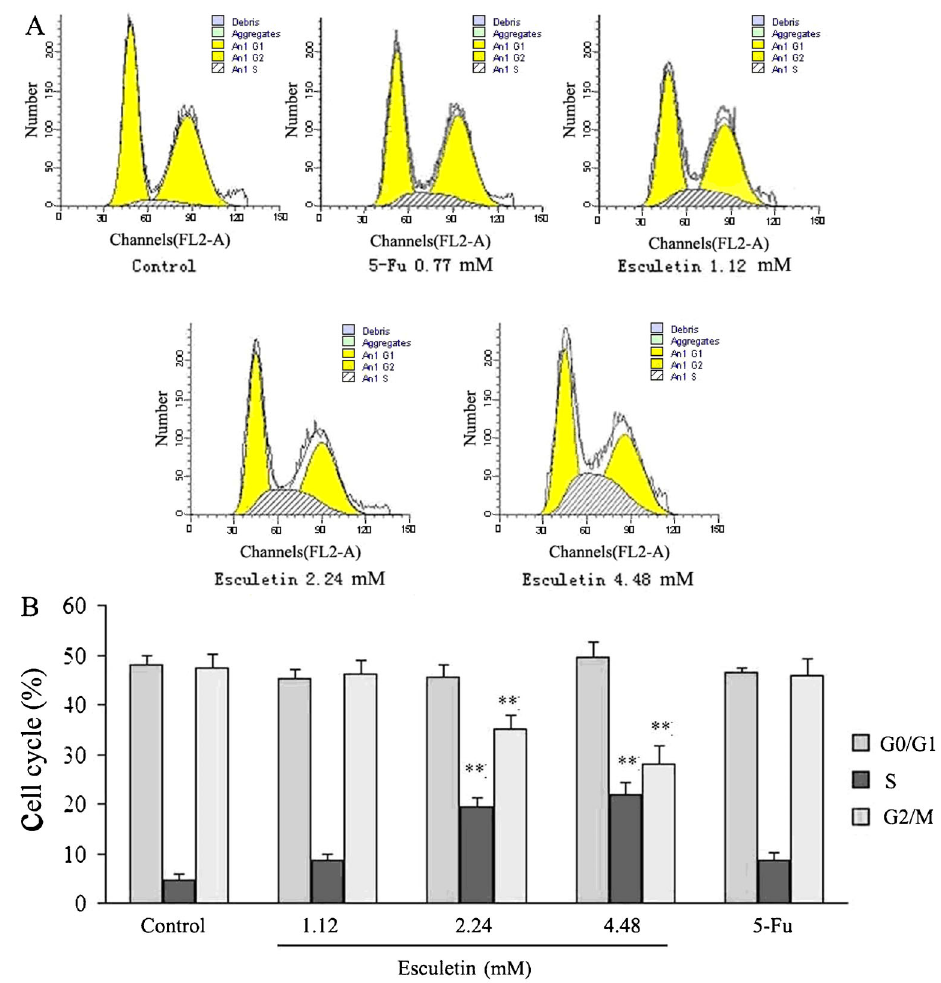
Figure 2. Effects of esculetin on the cell cycle of SMMC-7721. SMMC-7721 cells were seeded at a density of 1 6 10 5 /mL cells per culture flask for 24 h, and harvested after treatment with esculetin (0, 1.12, 2.24, and 4.48 mM) and 5-FU (0.77 mM) for 48 h. Cell cycle distributions in SMMC-7721 cells were determined by PI staining and flow cytometry analysis. Data were analyzed using the Bioconsort software and are reported as means±SD. **P , 0.01 vs control group (one-way ANOVA followed by Bonferroni’s